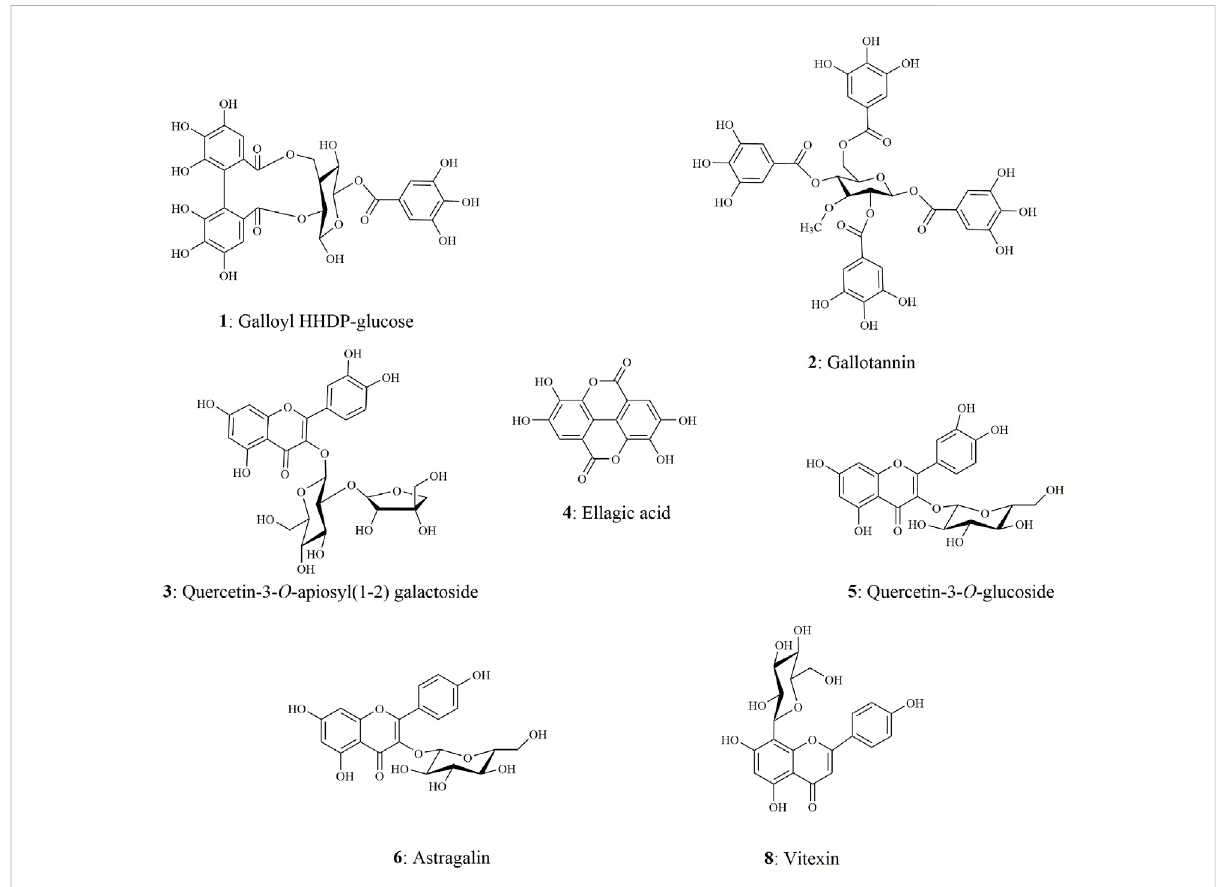
FIGURE 3 Chemical structures of the seven identi fi ed compounds from